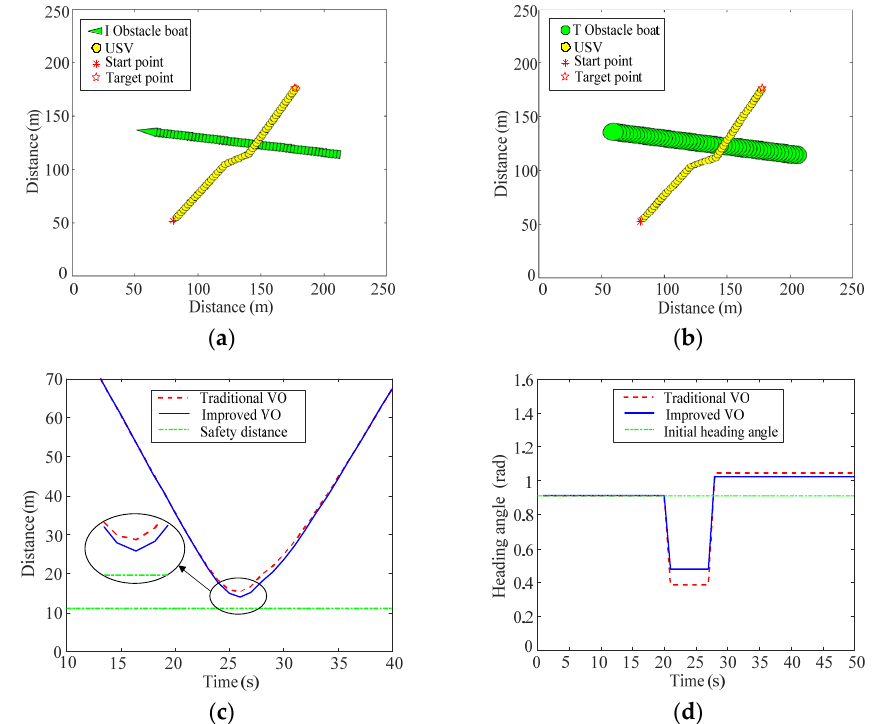
Figure 7. Simulation comparison of crossing from the right scene: ( a ) improved VO path simulation; ( b ) traditional VO path simulation; ( c ) relative distance comparison graph; ( d ) USV heading angle comparison chart.